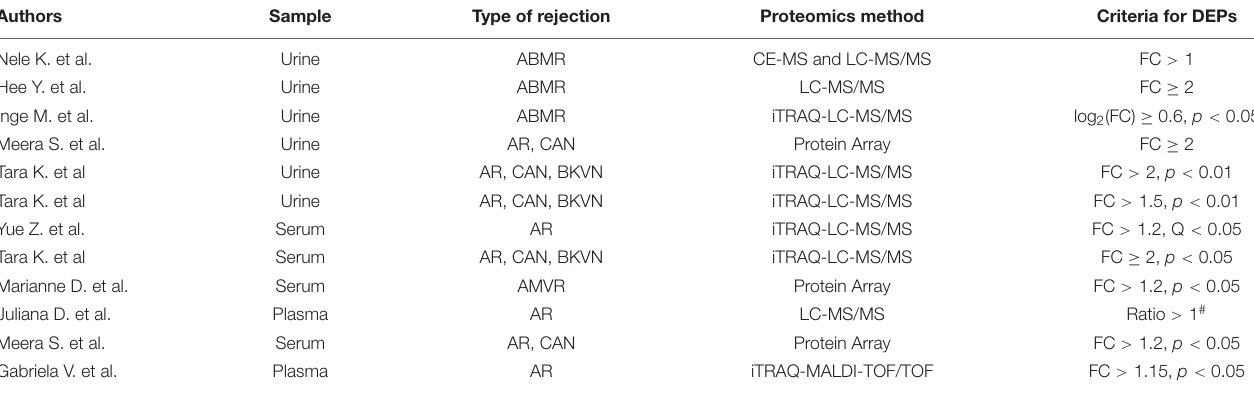
TABLE 1 | Summary of the selected proteomics studies.